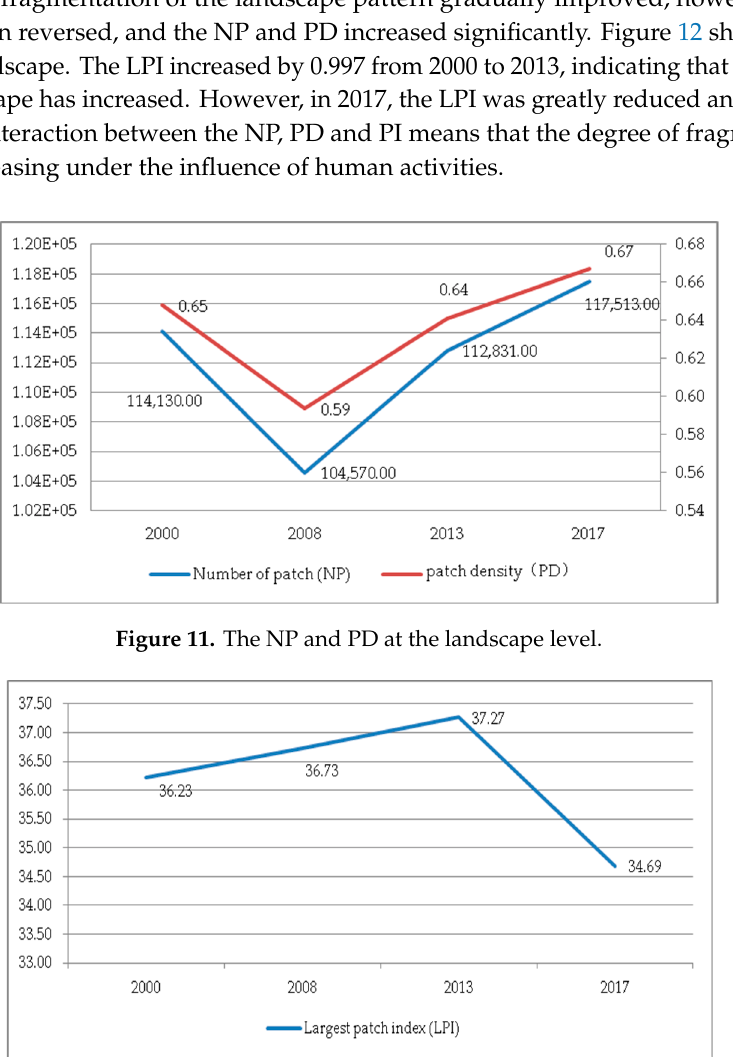
Figure 13. The LSI and perimeter - area fractal dimension (PAFRAC) at the landscape level.